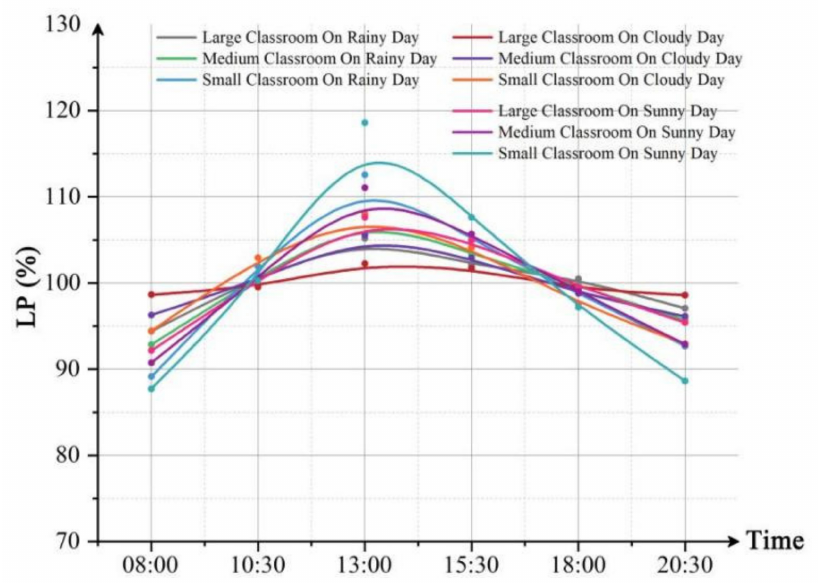
Figure 20. The LP of the learning efficiency test in the three classroom-types under different weather conditions throughout the